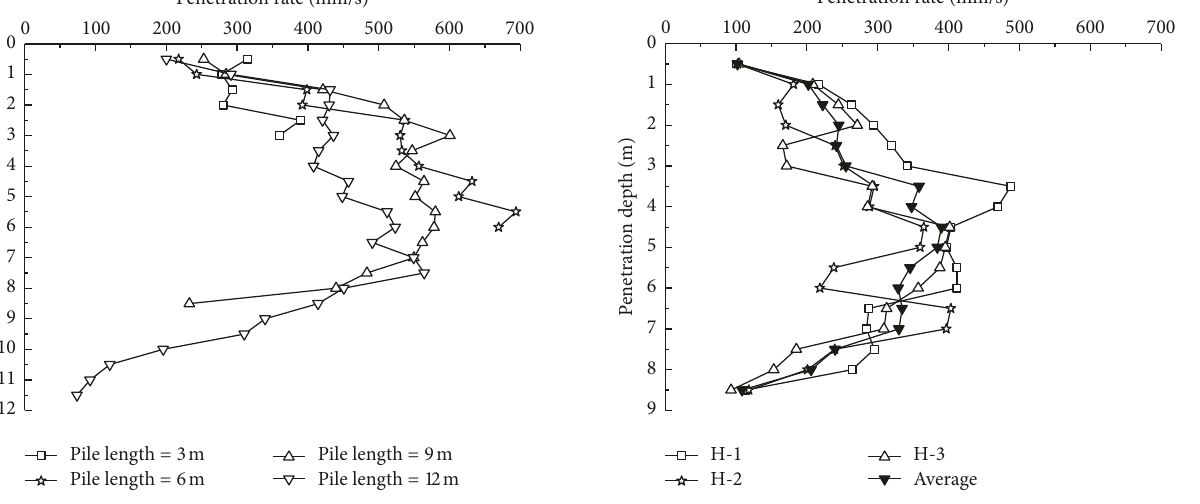
Figure 5: Penetration rate of piles with different lengths versus penetration depth.